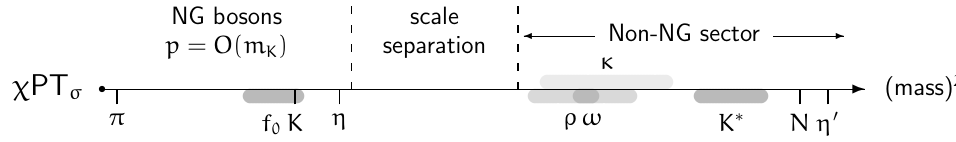
Figure 2. The hadronic spectrum below 1 GeV, seen from the point of view of χ PT σ . Masses and momenta p of NG bosons, including f 0 ( 500 ) , are small relative to scales of the non-NG sector. Please note that χ PT σ works only for N f = 3 light flavors; there is no analogue of it for N f = 2 m u , d because of the presence of the s quark: m s (cid:29)